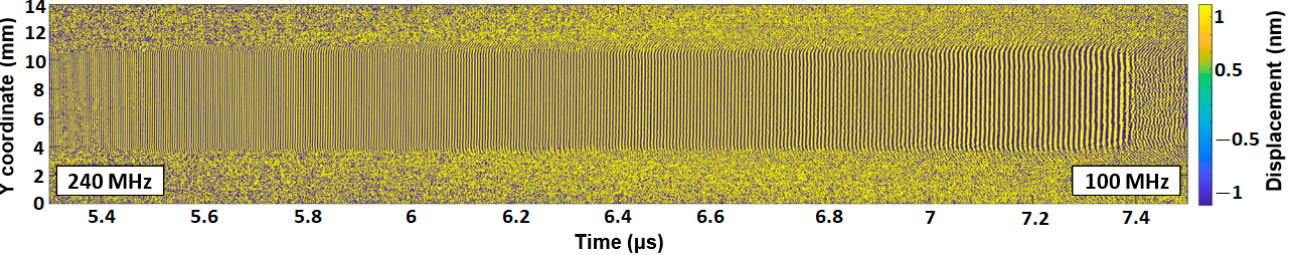
Figure 6. Schematic diagram of the measuring principle.